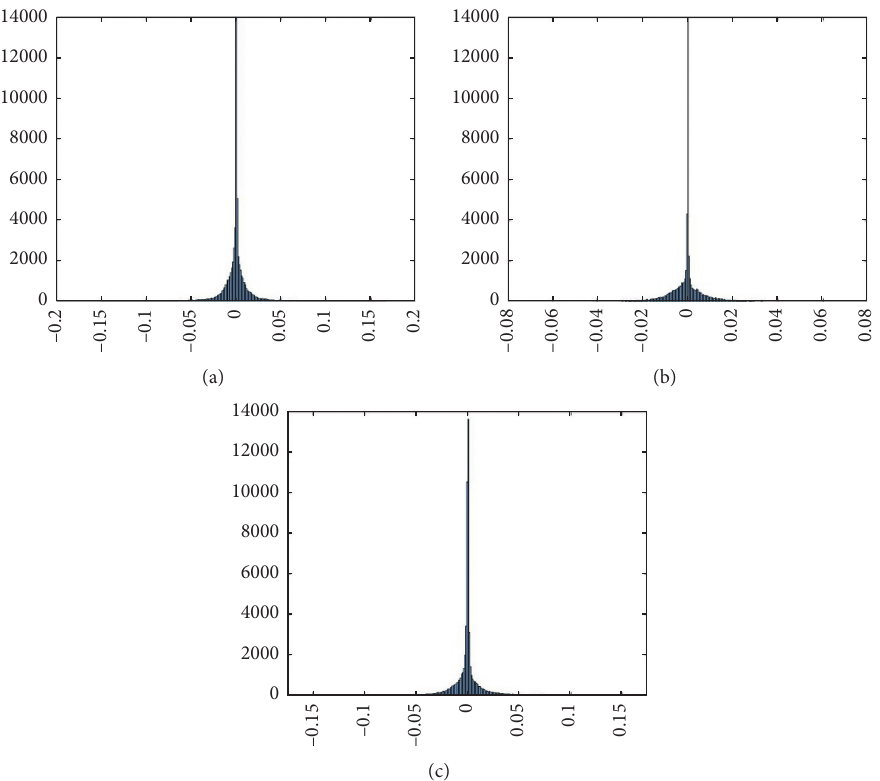
Figure 16: Histogram of speech signal extraction under quantum chaos: (a) SA1 speech signal; (b) SA2 speech signal; (c) SI943 speech